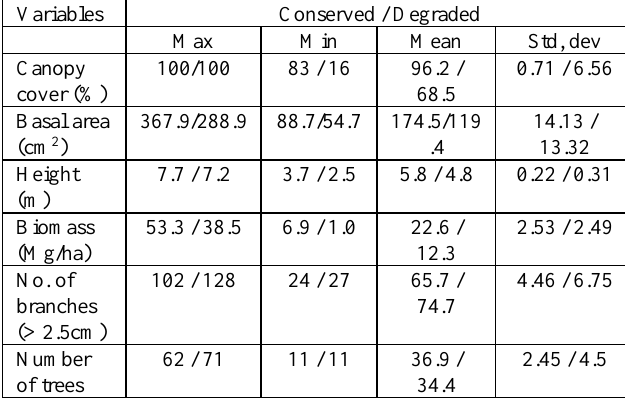
Table 1. Summary of forest structural parameters between conserved and degraded forests.